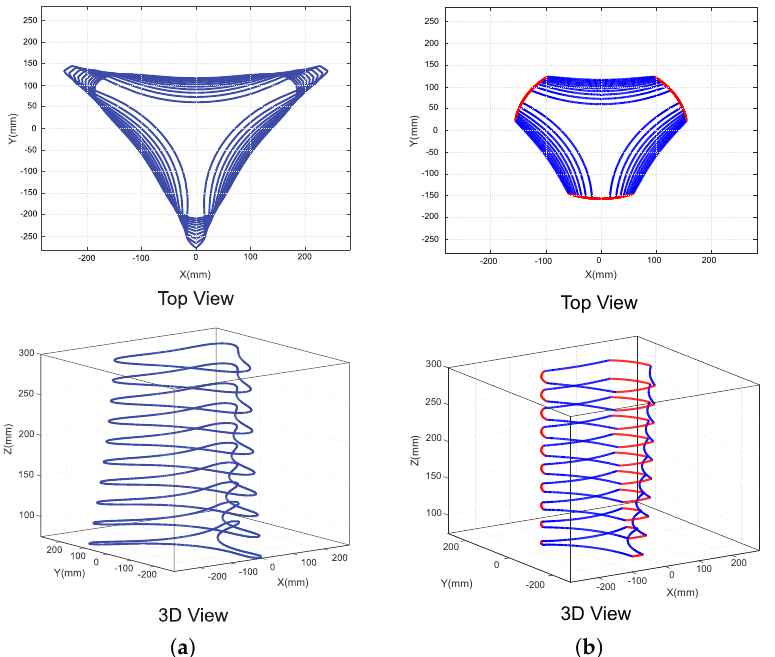
Figure 9. Workspace bounded by singularity loci: ( a ) Hybrid Mechanism 1 and ( b ) Hybrid Mechanism